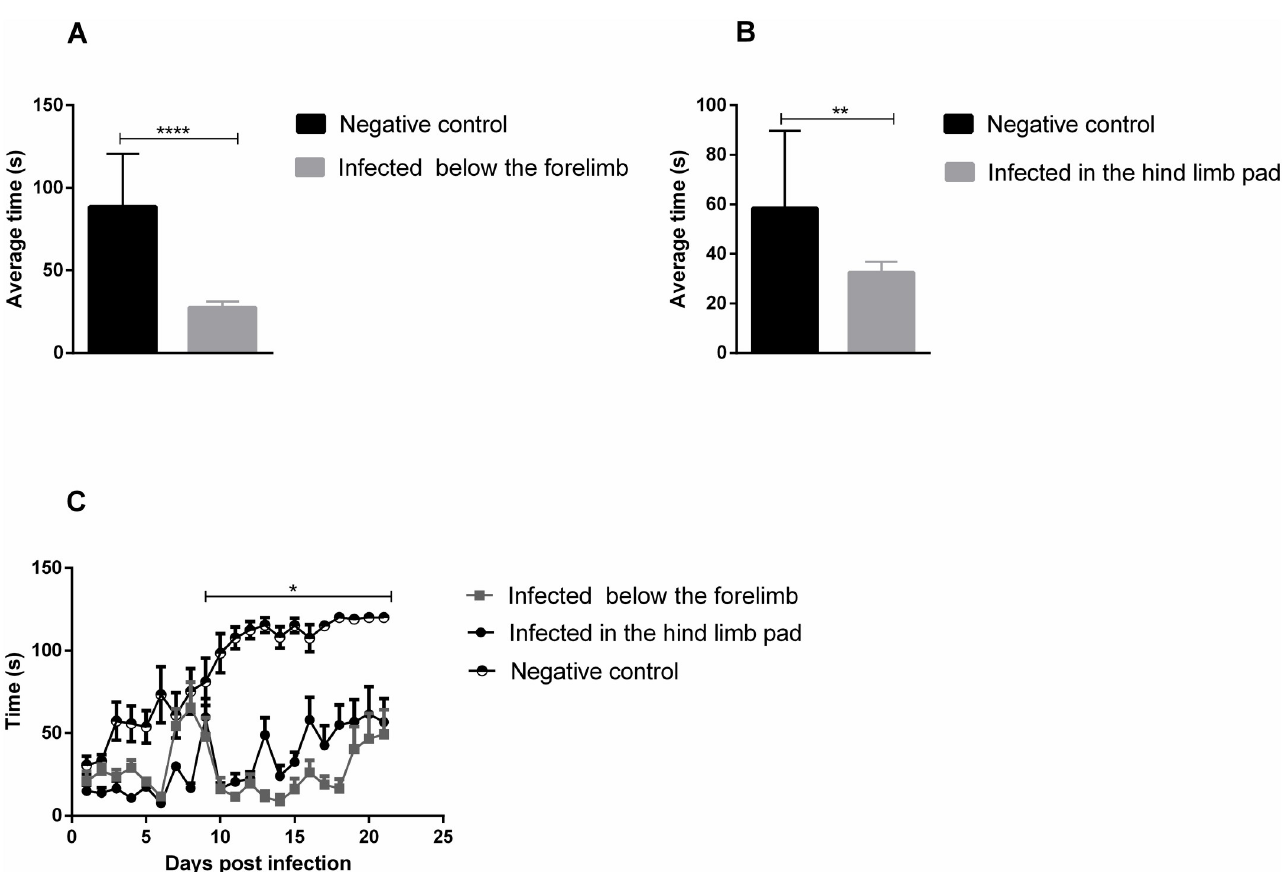
Fig 4. Evaluation of muscle weakness in 15-day-old Balb/c mice. Mice were subjected to the Wire-hang physical test at 24-hour intervals. 15-day old Balb/c mice were infected with 2.57 x 10 6 PFU in the rear footpad and 1.25 x 10 7 PFU below the forelimb by subcutaneous injection. Control groups received only PBS 1X. (A and B) average time that animals were able to remain attached to the grid, infected groups presented significantly lower means than the control time. (C) Behavior of the groups throughout the experiment. Statistics were performed with two-way ANOVA, Tukey’s multiple comparisons test. ( � P value � 0.05; �� P value < 0.0034; ���� P value < 0.0001). N = 12 animals/group.